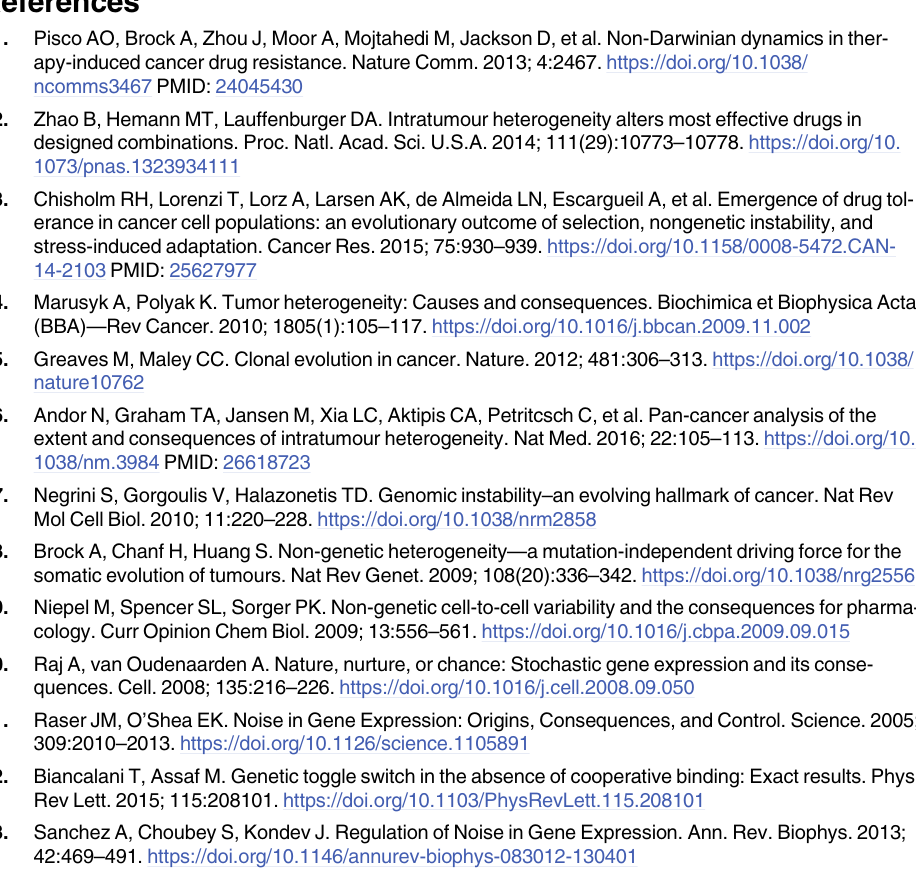
S1 Table. Definition of the estimates or proxies for the activity of the chromatin modifiers. Statistics regarding these quantities are shown in Figs 4 and 7. Recall